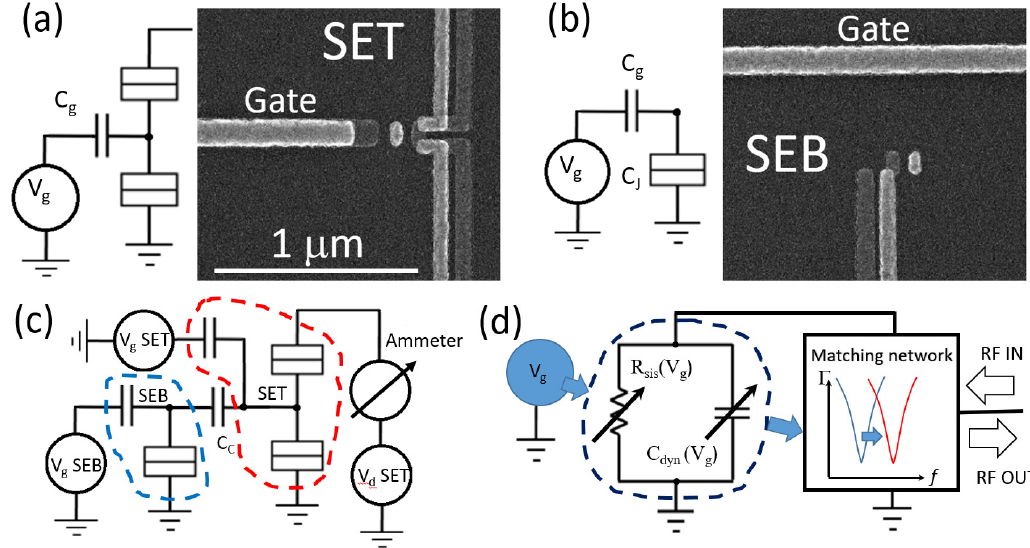
Figure 1. Schematic diagrams and scanning electron micrographs of a single electron transistor ( a ) and single electron box ( b ) fabricated by the Dolan bridge technique. The scale bar is the same for both cases. ( c ) Simplified circuit diagram of the experiment in [17] where the single-electron transistor (SET), delineated by a red dashed line, is employed to probe single-electron charging in single-electron box (SEB), delineated by a blue dashed line. The SEB is coupled to the SET using a coupling capacitor C C . ( d ) Functional diagram of the SEB measurement by an RF reflectometry setup. R Sis and C dyn represent contribution to the change in total impedance of SEB from Sisyphus resistance and dynamic capacitance. These two e ff ects associated with single electron tunneling in and out of SEB cause variations in the matching network and thus a ff ect the reflected